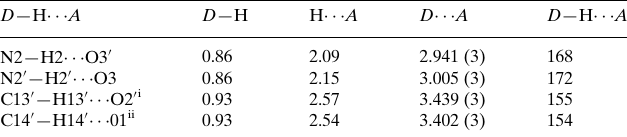
Hydrogen-bond geometry (A˚ , (cid:2)